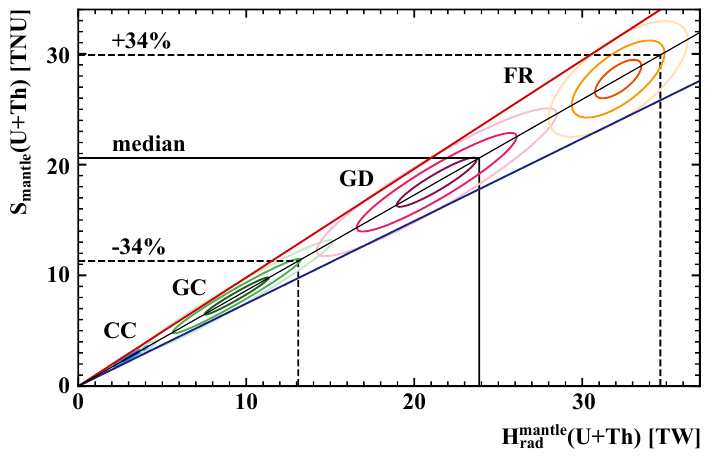
Figure 18. Mantle geoneutrino signal expected in Borexino as a function of 238 U and 232 Th mantle radiogenic heat: the area between the red and blue lines denotes the full range allowed between a homogeneous mantle (high scenario) and a unique rich layer just above the CMB (low scenario). The slope of the central inclined black line ( β centr = 0.86TNU/TW) is the average of the slopes of the blue and red lines. The blue, green, red, and yellow ellipses are calculated using the 238 U and 232 Th mantle radiogenic power (with 1 σ error) according to different BSE models: Cosmochemical (CC) model, Geochemical (GC) model, Geodynamical (GD) model, and Fully radiogenic (FR) model. For each model darker to lighter shades of respective colors represent 1, 2, and 3 σ contours. The black horizontal lines represent the mantle signal measured by Borexino: the median mantle signal (solid line) and the 68% coverage interval (dashed lines). From [19]. H radmantle (U+Th+K)H SC H LSp rad (U+Th+K)